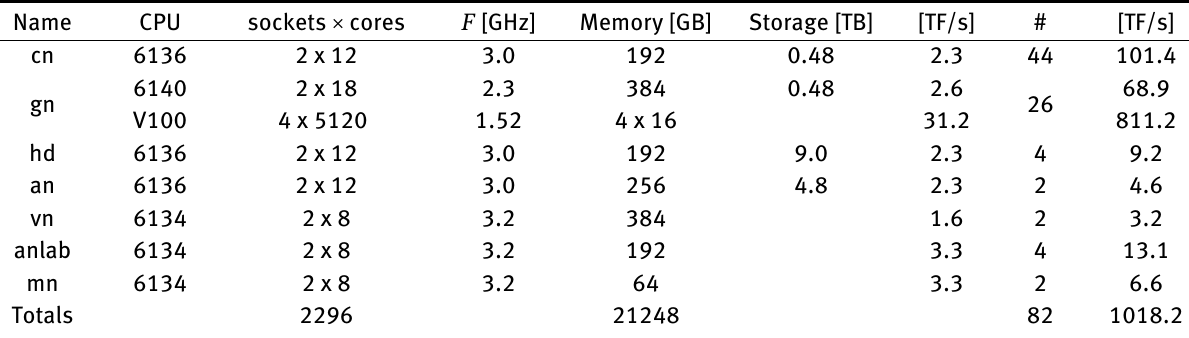
Table 1: Details of named “Zhores” cluster nodes